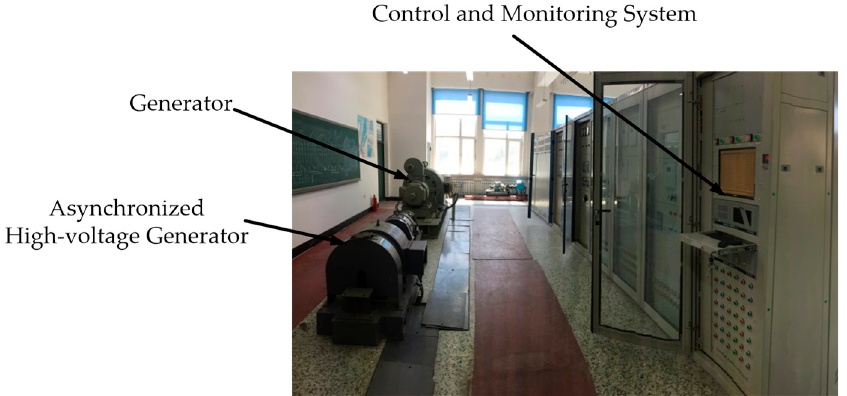
Figure 6. Experiment of the asynchronized high-voltage generator for a loss of excitation.